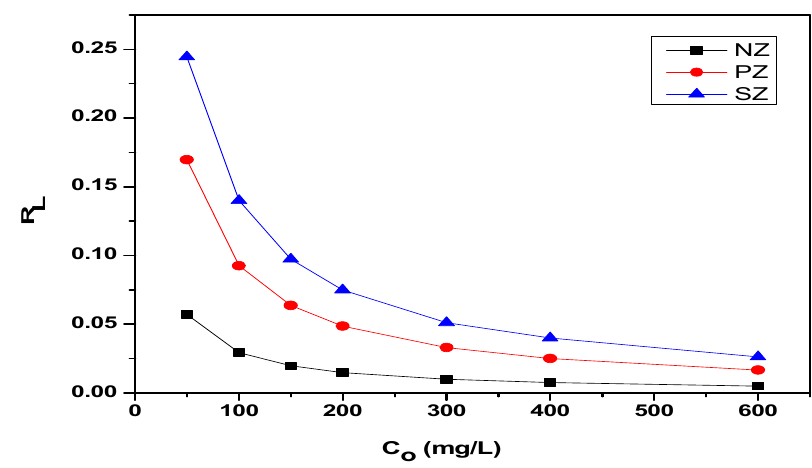
Figure 12. The separation factor (R L ) for the adsorption of thorium onto NZ, PZ, and SZ.